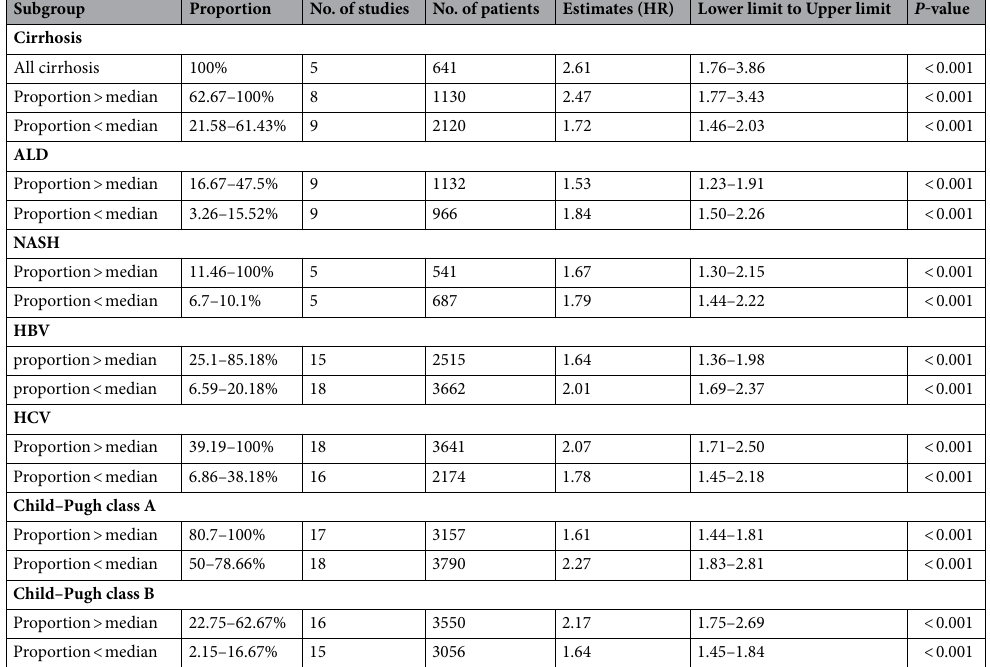
Table 2. Different liver diseases and liver functional reserve. AH alcohol-related liver disease, NASH nonalcoholic steatohepatitis, HBV hepatitis B Virus, HCV hepatitis C Virus.